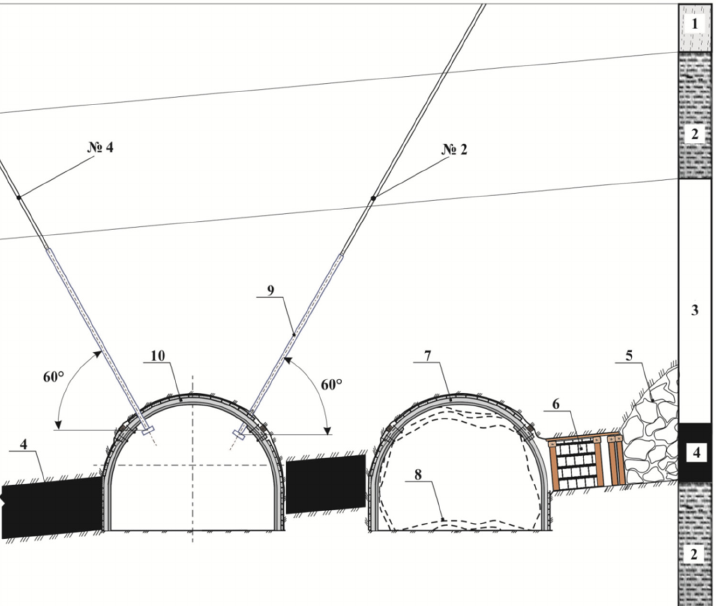
Figure 1. The sink scheme of wells of various types in the excavation area: 1—gray sand- stone;2—dark gray siltstone; 3—mudstone; 4—seam m 3 ; 5—mined-out space of previously worked out longwall; 6—bi-support; 7—belt road of 17th eastern longwall; 8—contour deformations; 9—casing; 10—air drift of 18th eastern longwall.